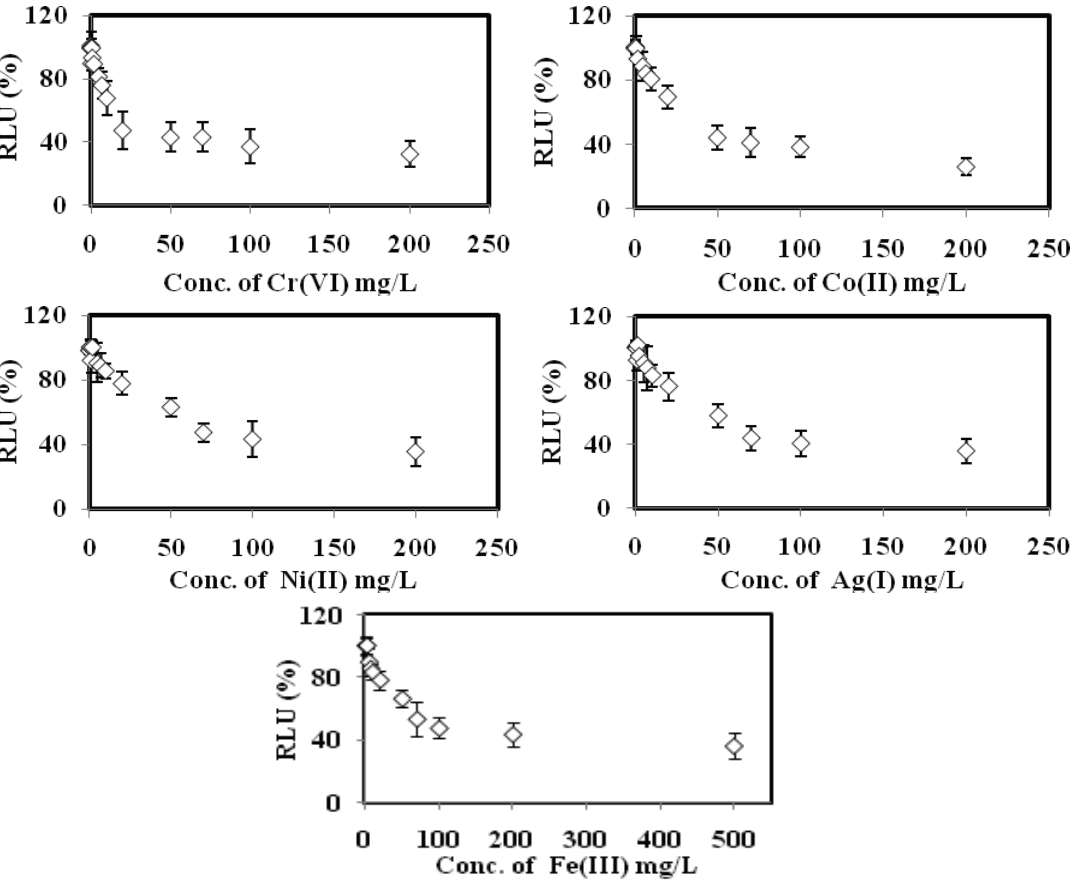
Table 2. The bioluminescent microoptode performance towards Cu(II), Cd(II),